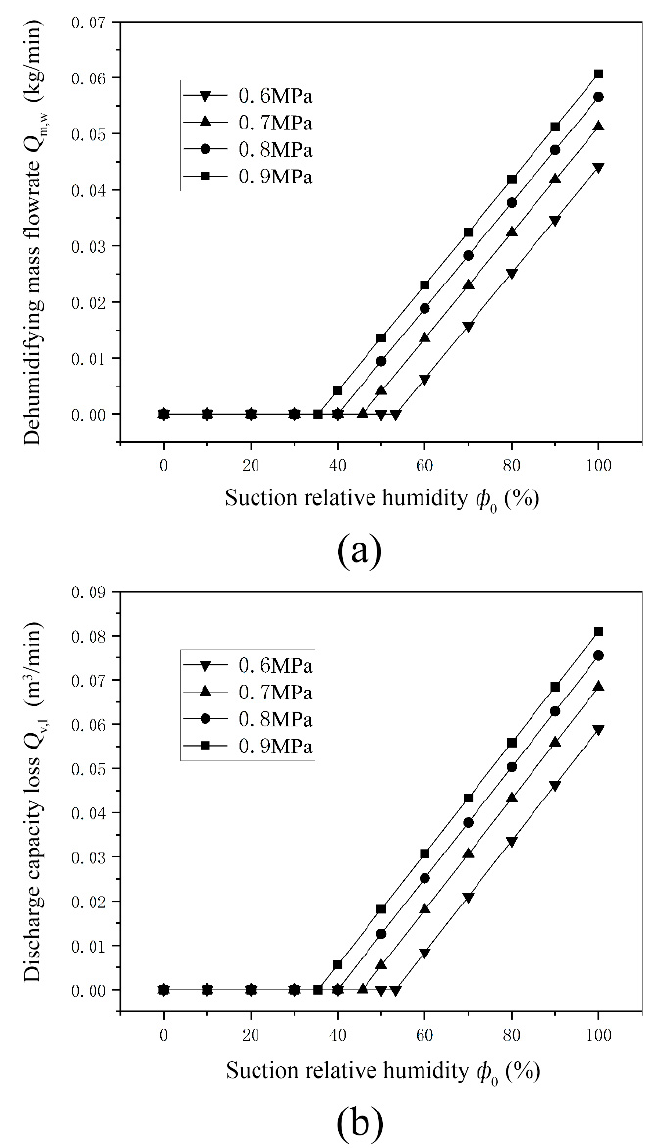
Figure 6. The influence of suction relative humidity on the dehumidifying process: ( a ) dehumidifying mass flow; ( b ) loss of discharge capacity.